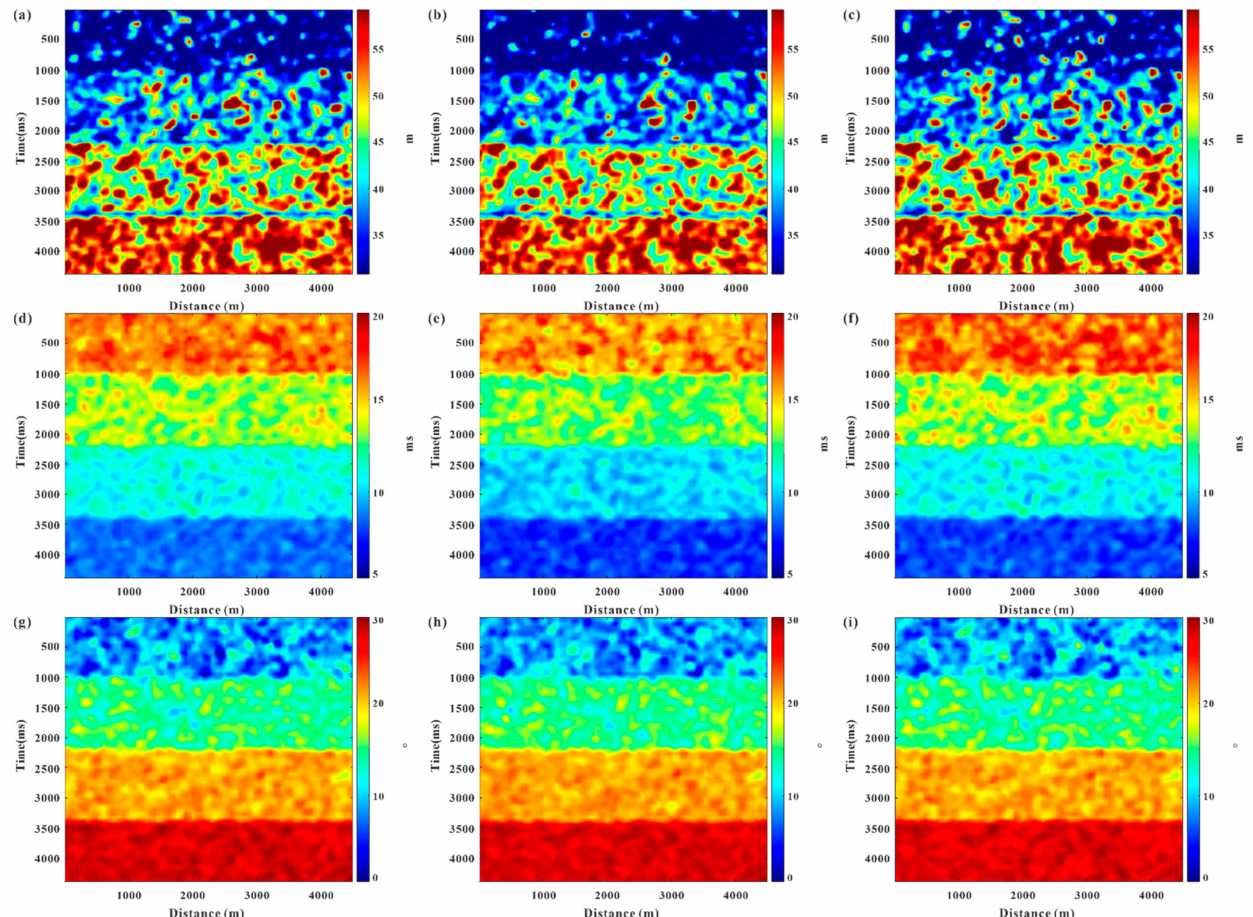
Figure 5. Estimation results of autocorrelation parameters of porosity, clay volume, and water saturation: ( a – c ) are the horizontal autocorrelation length of porosity, clay volume, and water saturation, respectively. ( d – f ) are the vertical autocorrelation length of porosity, clay volume, and water saturation, respectively. ( g – i ) are the autocorrelation angle of porosity, clay volume, and water saturation,